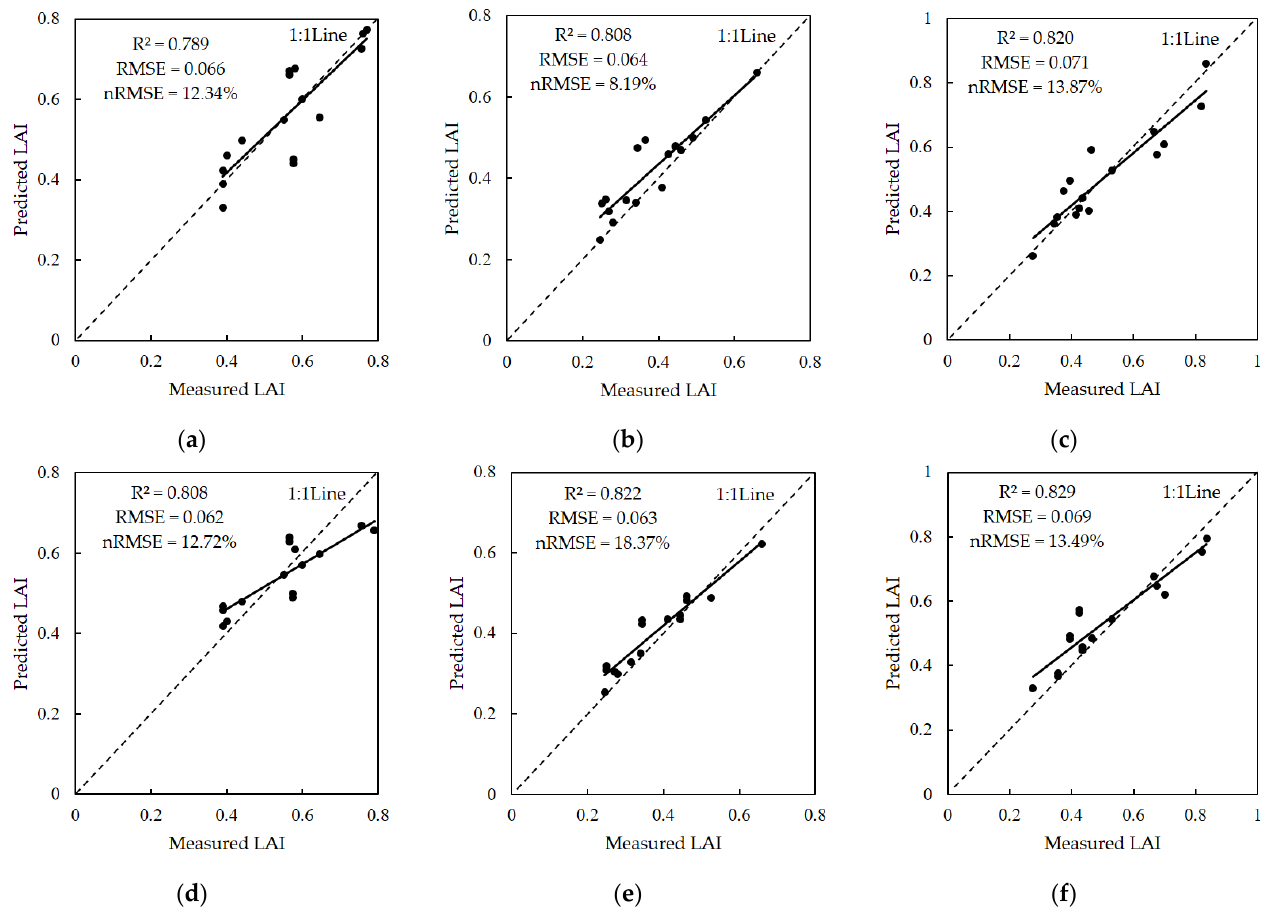
Figure 7. Validation results of combined texture feature models with SWR and RFR in each growth stage. ( a ) With SWR model in initial flowering stage (IF); ( b ) with SWR model in young fruit stage (YF); ( c ) with SWR model in fruit enlargement stage (FE); ( d ) with RFR model in initial flowering stage (IF); ( e ) with RFR model in young fruit stage (YF); ( f ) with RFR model in fruit enlargement stage (FE).